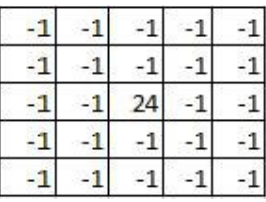
Figure 5. The 5  5 ideal high-pass kernel.